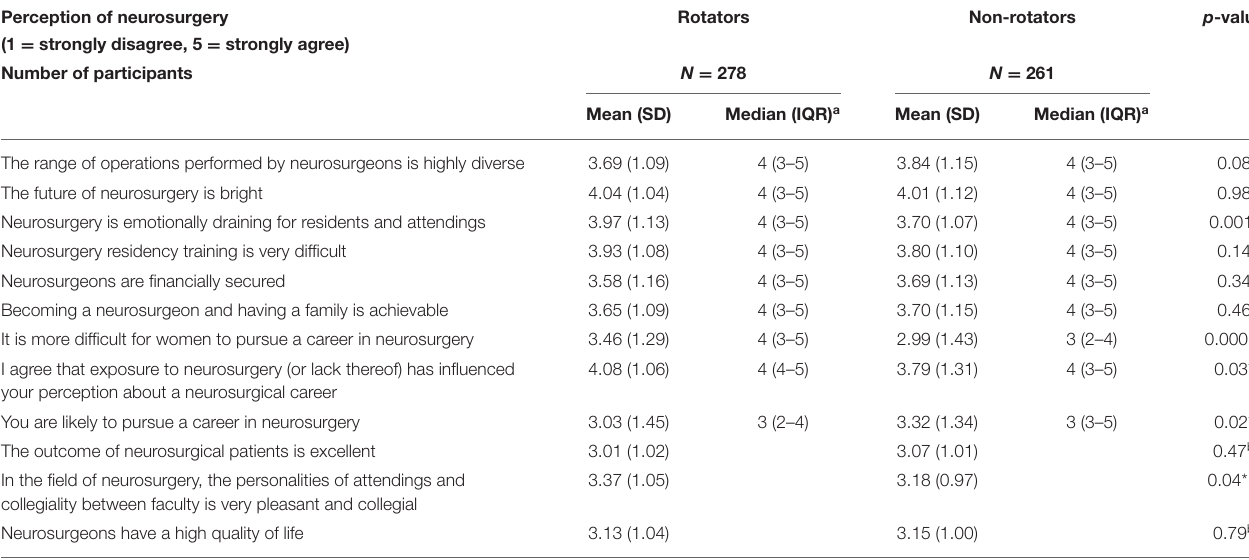
TABLE 3 | Perception of neurosurgery by formal neurosurgery clinical rotation experience. Perception of